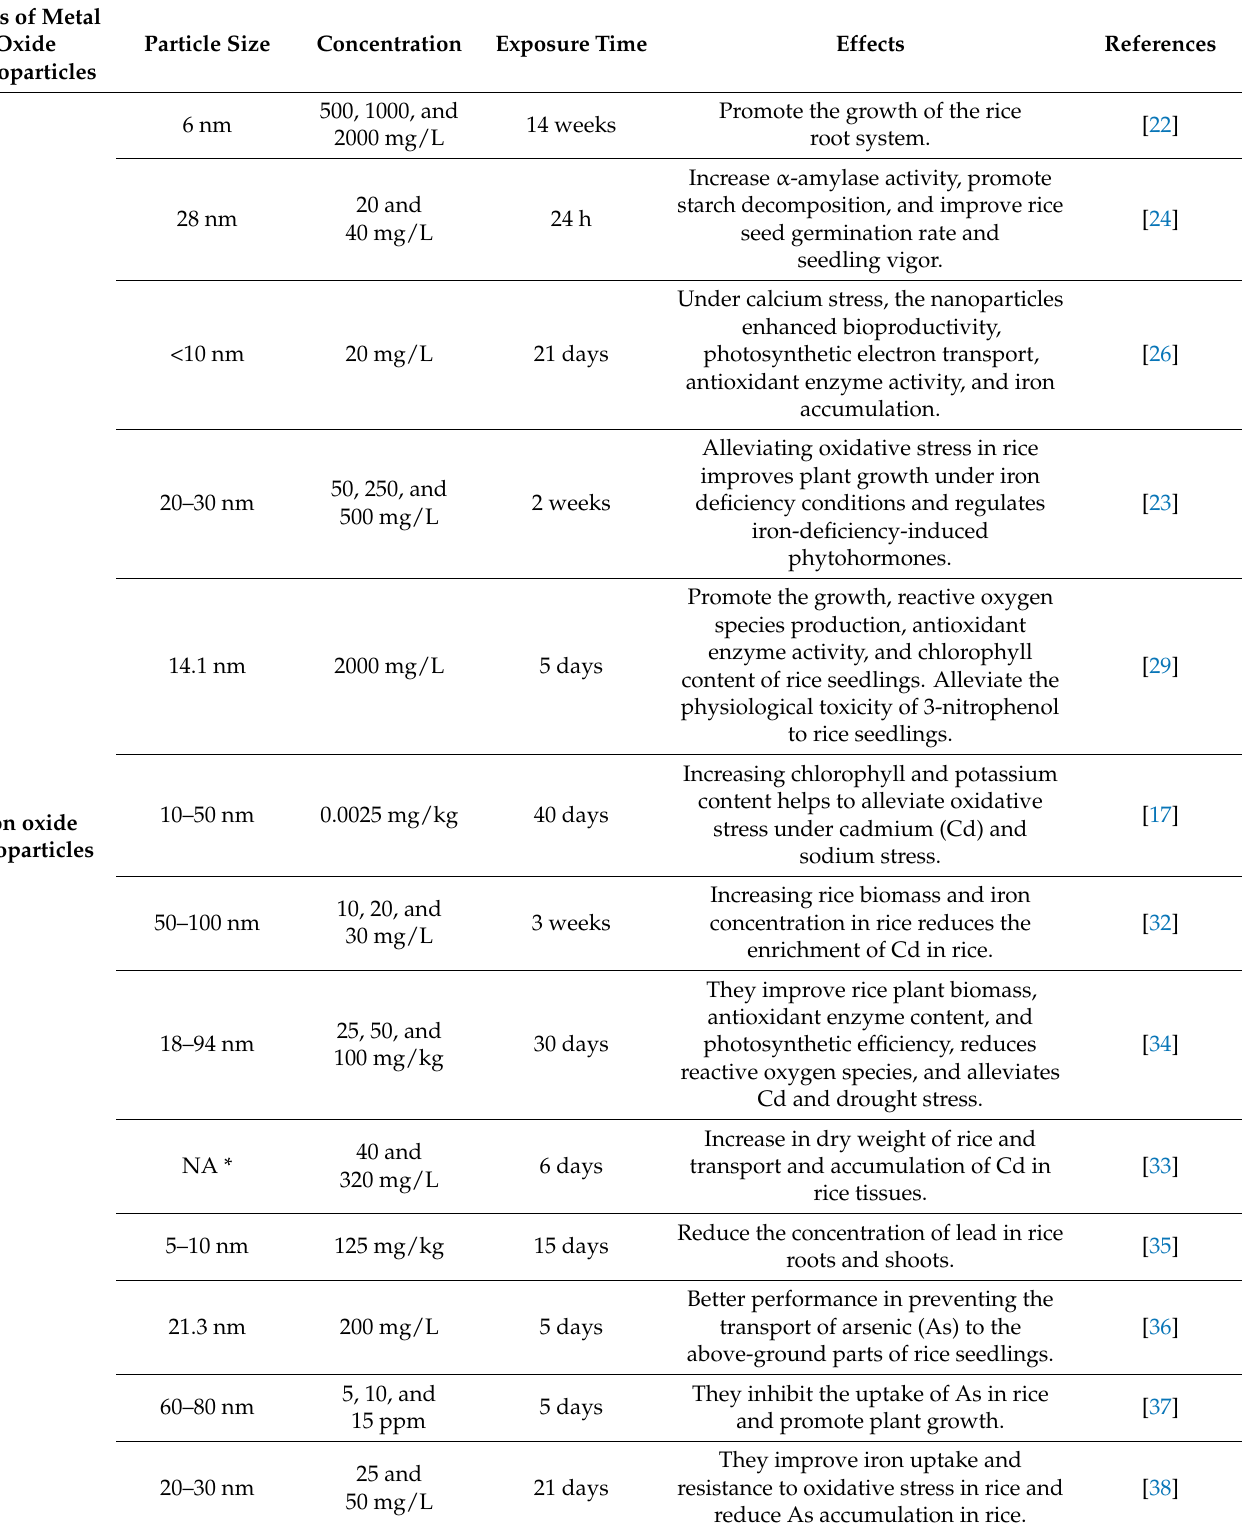
Table 2. Positive effects of metal oxide nanoparticles on rice